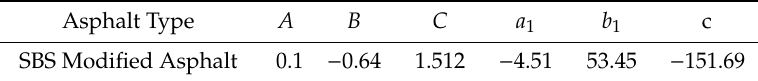
Table 7. Fitting parameters of linear model under di ff erent oil-stone